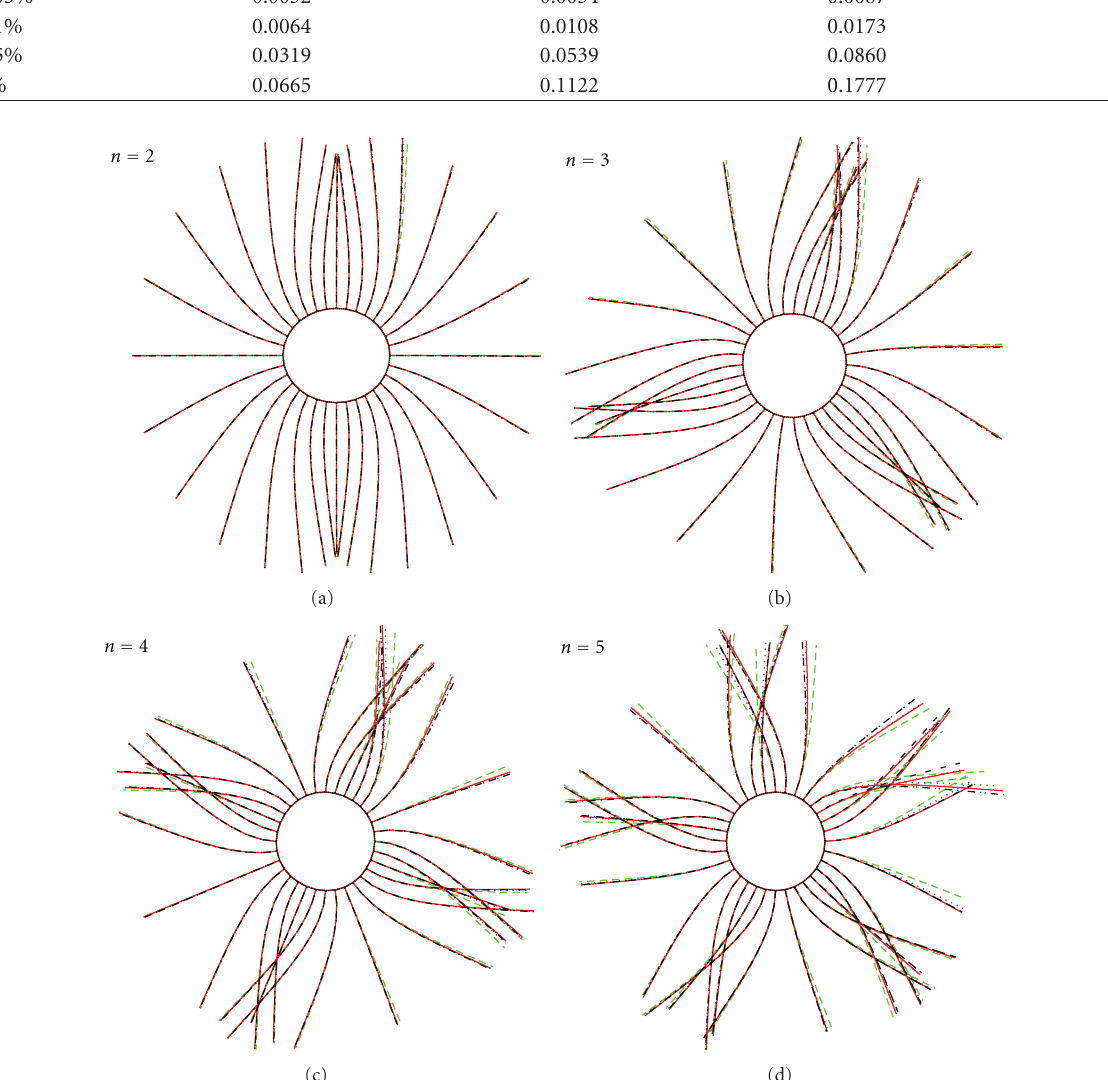
Figure 4: Eigenmodes of the imperfect rotor, evaluated according to the HOM model, the L-HOM model, and the EB model. The imperfection is introduced by increasing the mass of the fourth blade of the perfect rotor described in Section 4.1 by γ = 1%, with respect to its nominal value. –– green: perfect rotor, — red: imperfect rotor using HOM model, · · · blue: imperfect rotor using L-HOM model, – · – black: imperfect rotor using the EB